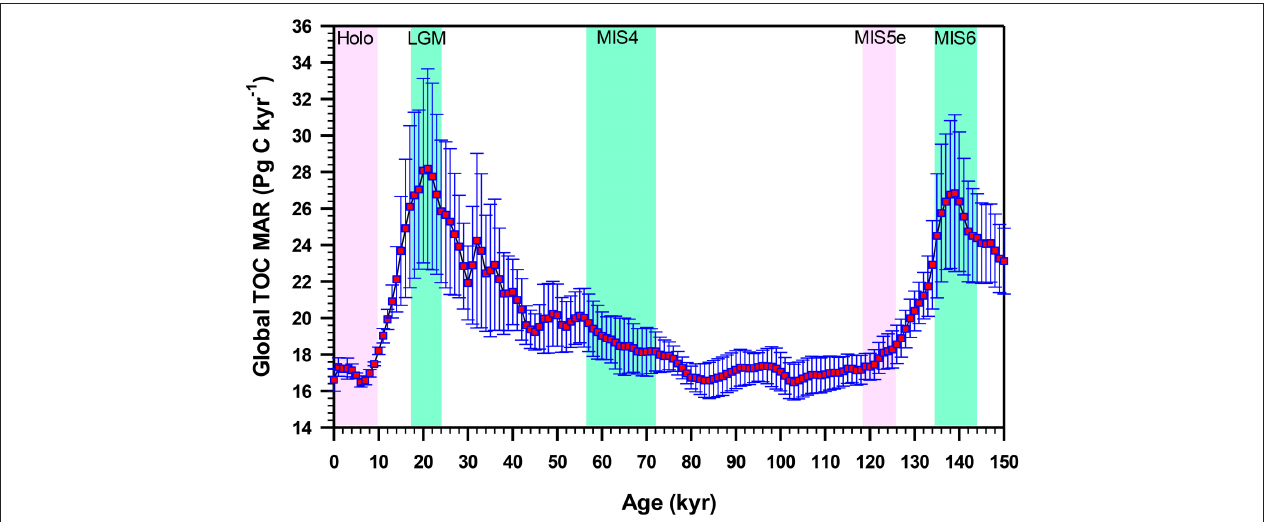
FIGURE 4 | Reconstructed global mean (with standard deviation) mass accumulation rate of total organic carbon (TOC MAR) in deep sea sediments showing higher TOC MAR during glacial intervals compared to interglacial periods (Redrawn from Cartapanis et al., 2016). Pink vertical bars correspond to interglacial periods (Holocene and Marine Isotope Stage (MIS) 5e; light green vertical bars correspond to glacial intervals (Last Glacial Maximum (LGM), MIS 4, and MIS